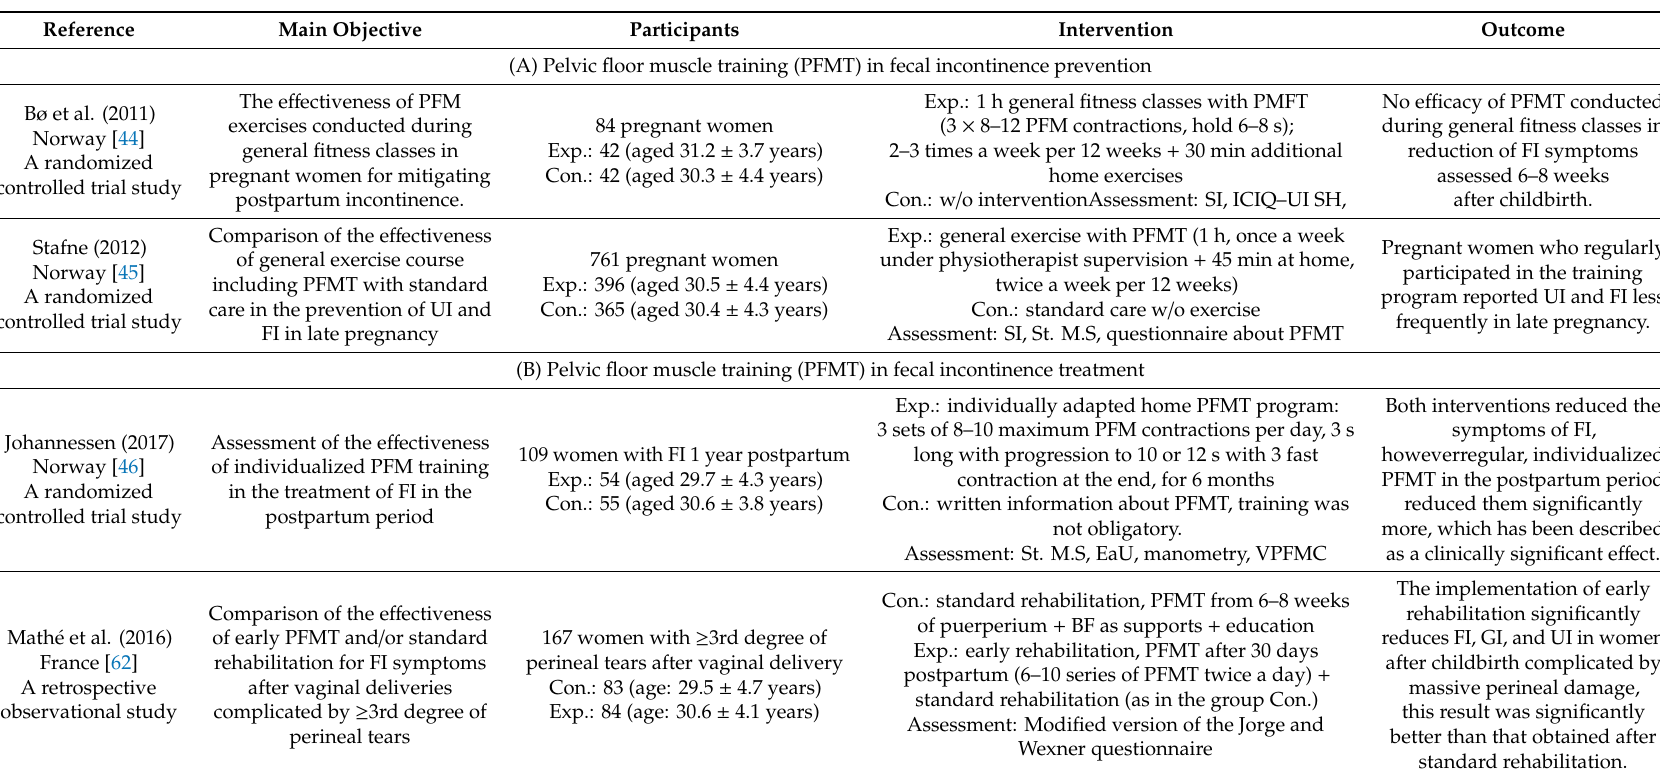
Table 4. Characterization of selected studies on the e ff ects of pelvic floor muscle training (PFMT) on the fecal incontinence prevention (A) and treatment